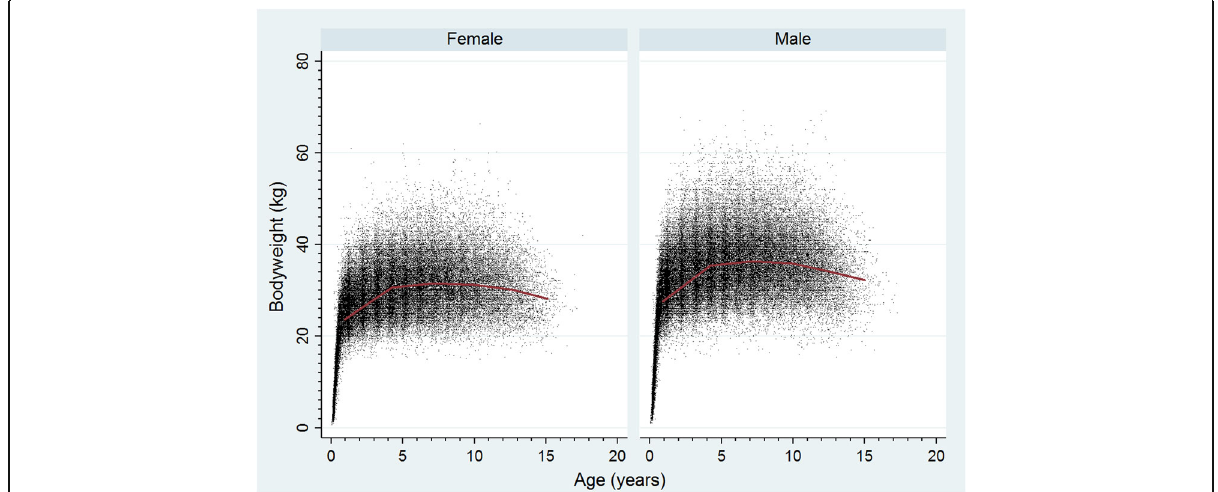
Fig. 2 Bodyweight growth curves overlaid with a cross medians line plot for female and male Labrador retrievers attending UK primary-care veterinary clinics participating in the VetCompass ™ Programme. (Females n = 10,228, Males n =